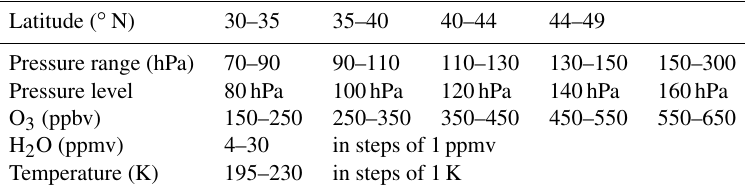
Table 2. Overview of the latitude, pressure, ozone, H 2 O and temperature ranges, for which CLaMS simulations are conducted. Each com- bination of latitude, pressure and ozone range is summarized in a data group resulting in 100 different data groups. For a better overview in this paper, pressure levels are used to describe the pressure ranges (e.g. 80hPa level for the pressure range 70–90hPa). Latitude ( ◦